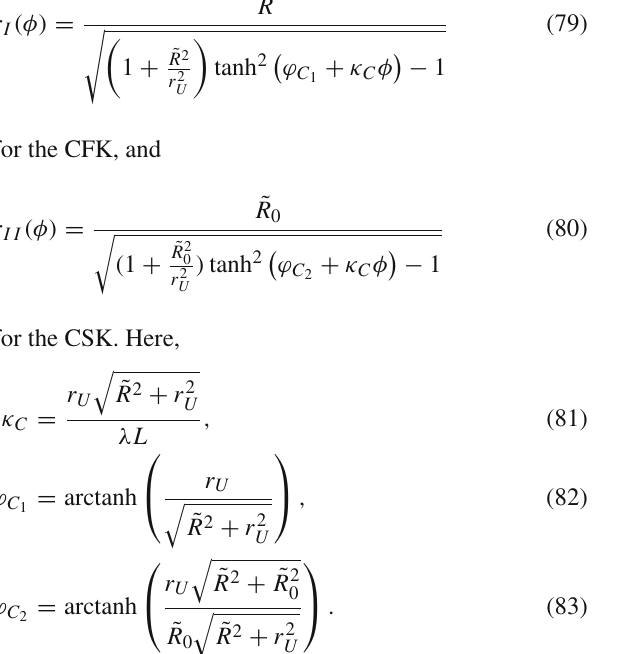
Fig. 9 Thecriticaltrajectories r I (φ) (blue)and r II (φ) (orange)plotted for Q = 1, λ = 10 and L = 2. For this values, E U ≈ 1 . 5 and r U ≈ 1 . 6 and the trajectories have been plotted for ˜ R ≈ 7 . 67 and ˜ R 0 = 1 . 3